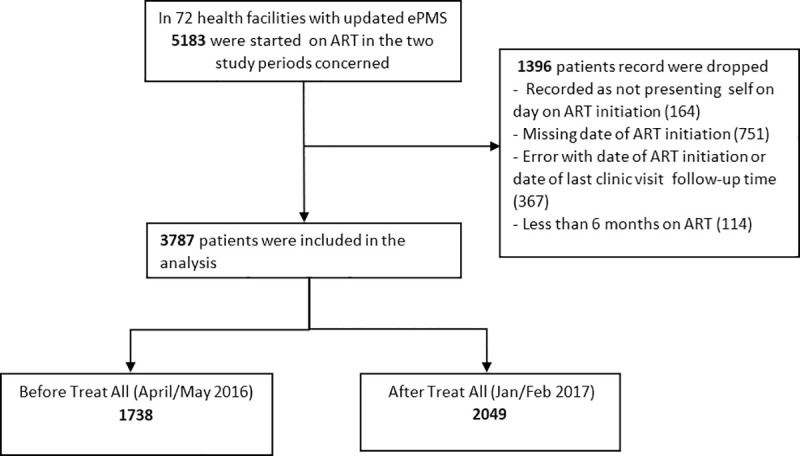
Study participants.